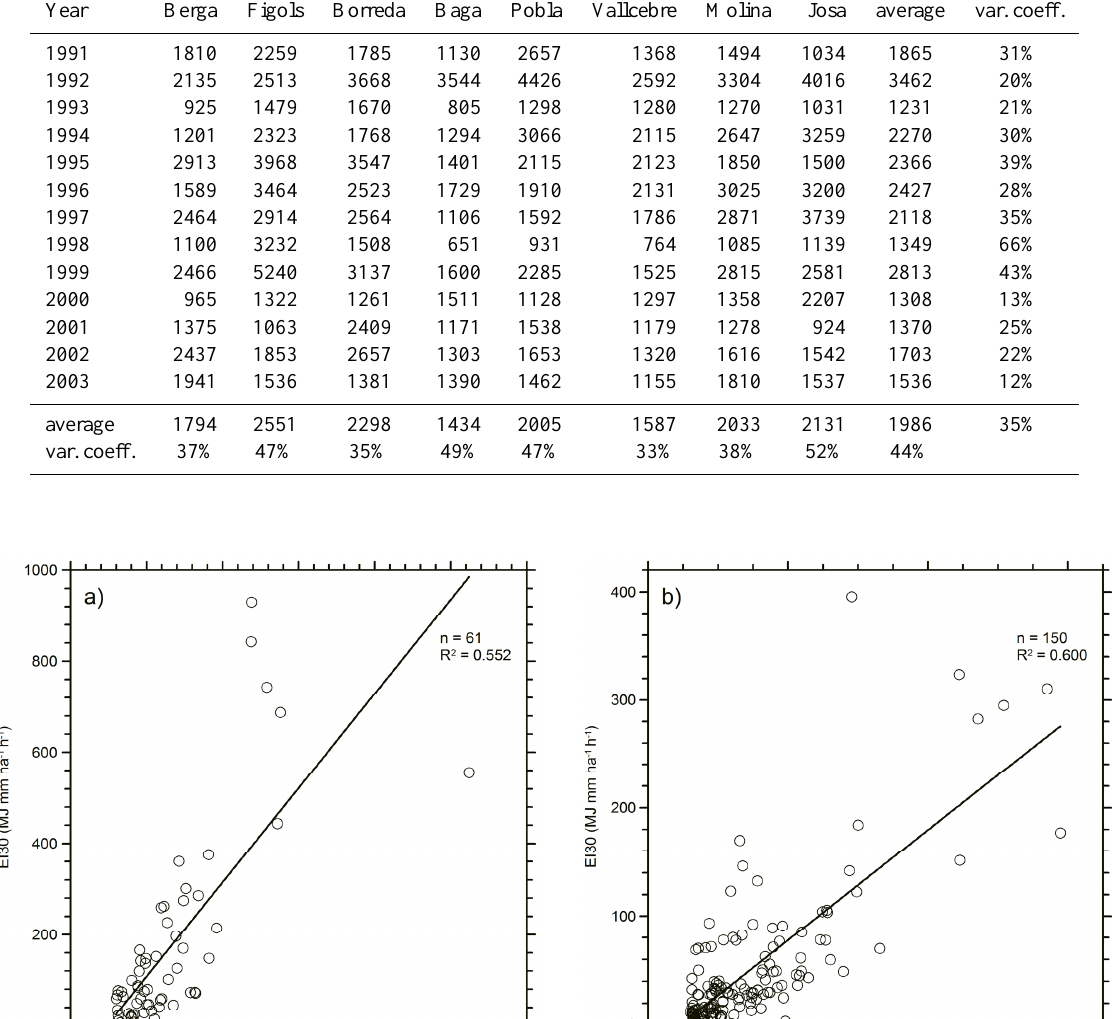
The uncertainty of the long-term total R value attributed to spatial variability was 125 MJ mm ha − 1 yr − 1 (6.4% of the R value), expressed in terms of the standard error of the mean because the stations were considered as nearly random ob- servations of the average value, whose error would decrease with a denser rainfall recording network. Temporal variability of the annual erosivity values at the stations was diverse, with variation coefficients between 33 and 52% and a weighted mean of